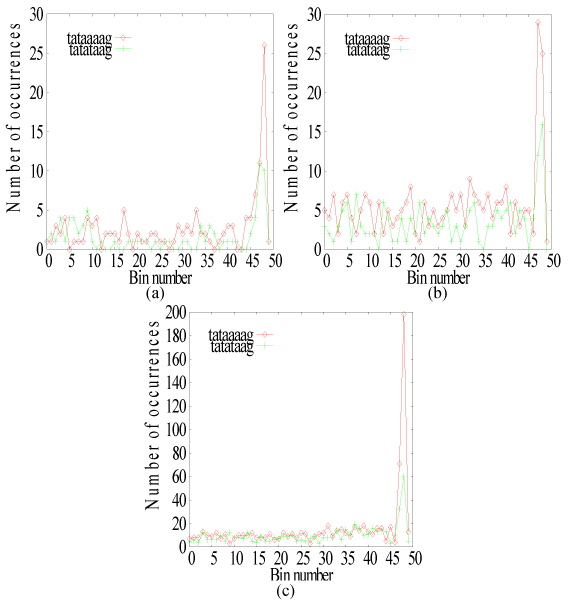
Frequency distribution of TATAAAAG and TATATAAG on three other organisms. TATAAAAG and TATATAAG are the two TATA elements which show peak pattern of frequency distribution in human promoters. The investigation on their frequency distribution on other three organisms shows the same pattern. Figure 5(a), (b) and (c) show their frequency distribution on the gene promoters of mice, zebrafish and drosophila melanogaster respectively.